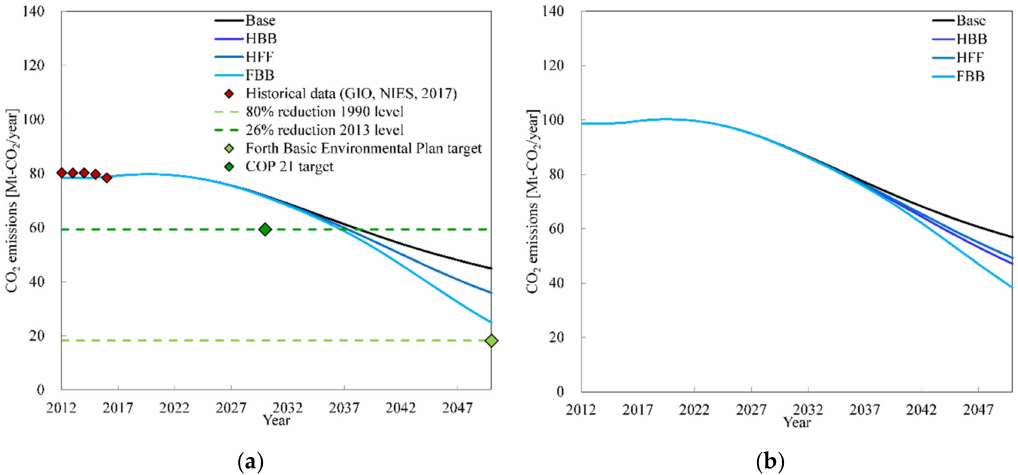
Figure 11. Road freight vehicle fleet CO 2 emissions. ( a ) Tank to wheel CO 2 emissions; ( b ) Well to wheel CO 2